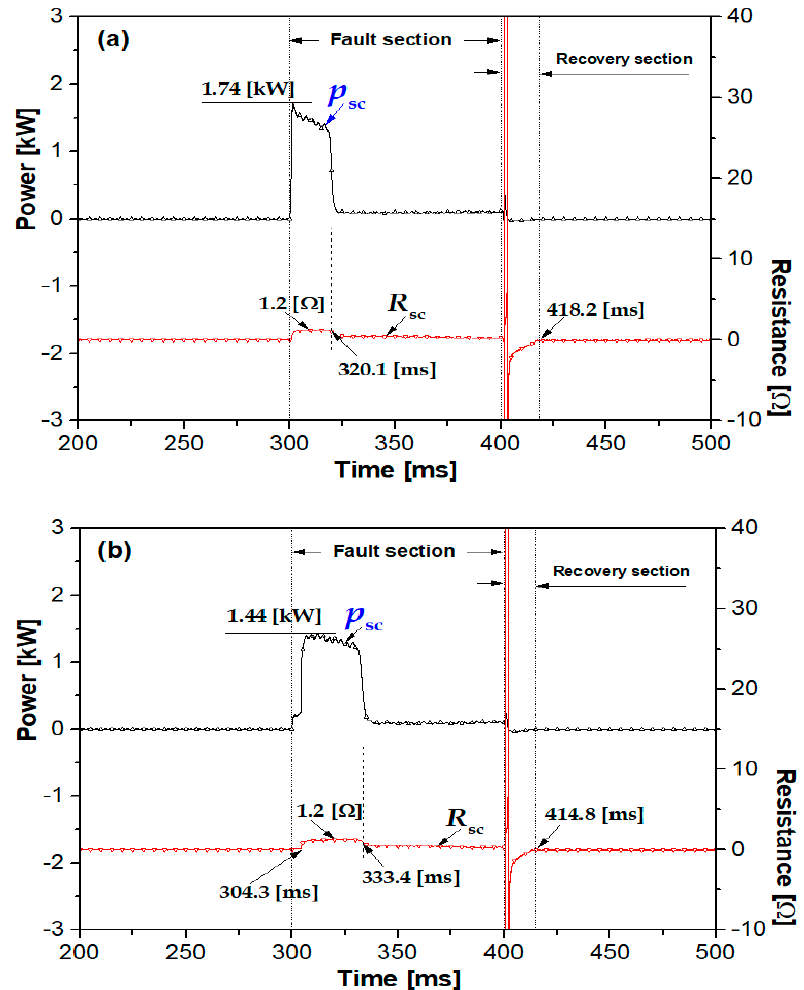
Figure 7. Power burden and SE resistance relationship of the flux-coupled type SFCL in accordance with the wiring direction: ( a ) for the additive wiring; ( b ) for the subtractive wiring. Figure 8 shows the magnetic flux ( 𝜙 ) and instantaneous power ( 𝑝 ) load of the two coils during the fault for both the additive wiring and subtractive wiring cases. It was found that the magnetic fluxes ( 𝜙 (cid:2869) ,𝜙 (cid:2870) ) of the primary and secondary coils were at similar levels regardless of the winding direction. The magnetic flux ( 𝜙 (cid:2869) ) of the primary coil was greater than that of the secondary coil ( 𝜙 (cid:2870) ). The maximum instantaneous power con- sumed in the primary and secondary coils immediately after the fault was slightly larger in the additive wiring than in the subtractive wiring. Additionally, the instantaneous power consumed in the secondary coil during the fault period was found to be larger in the additive wiring than in the subtractive wiring.